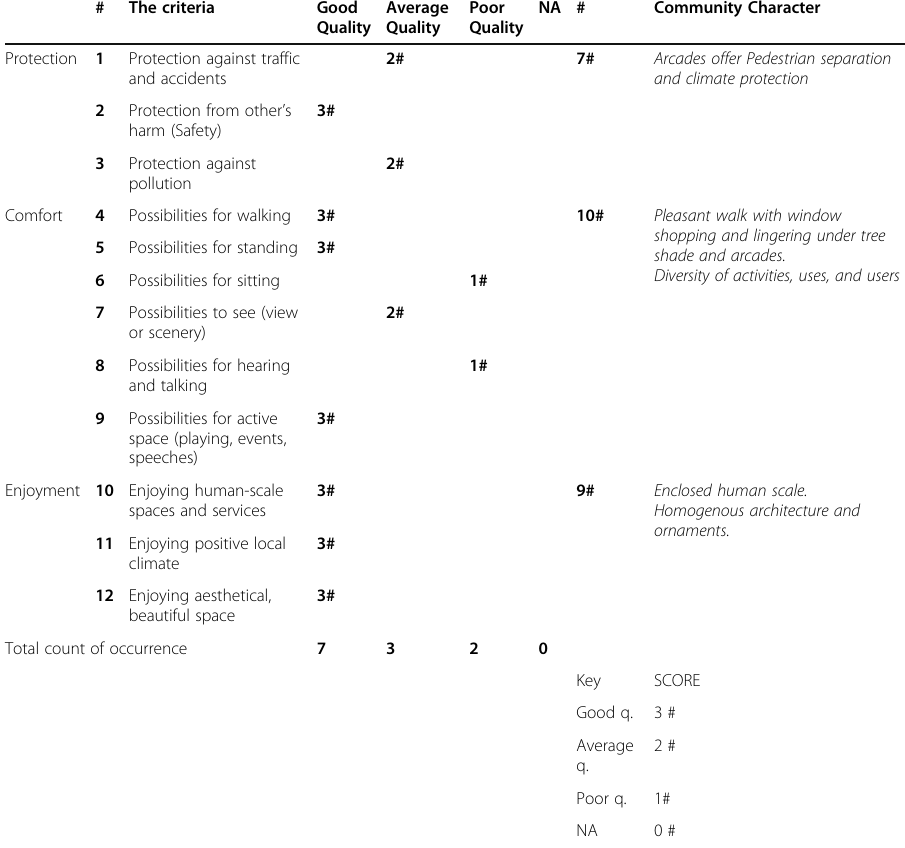
Table 1 Al Korba, Heliopolis public spaces assessment (Author) # The